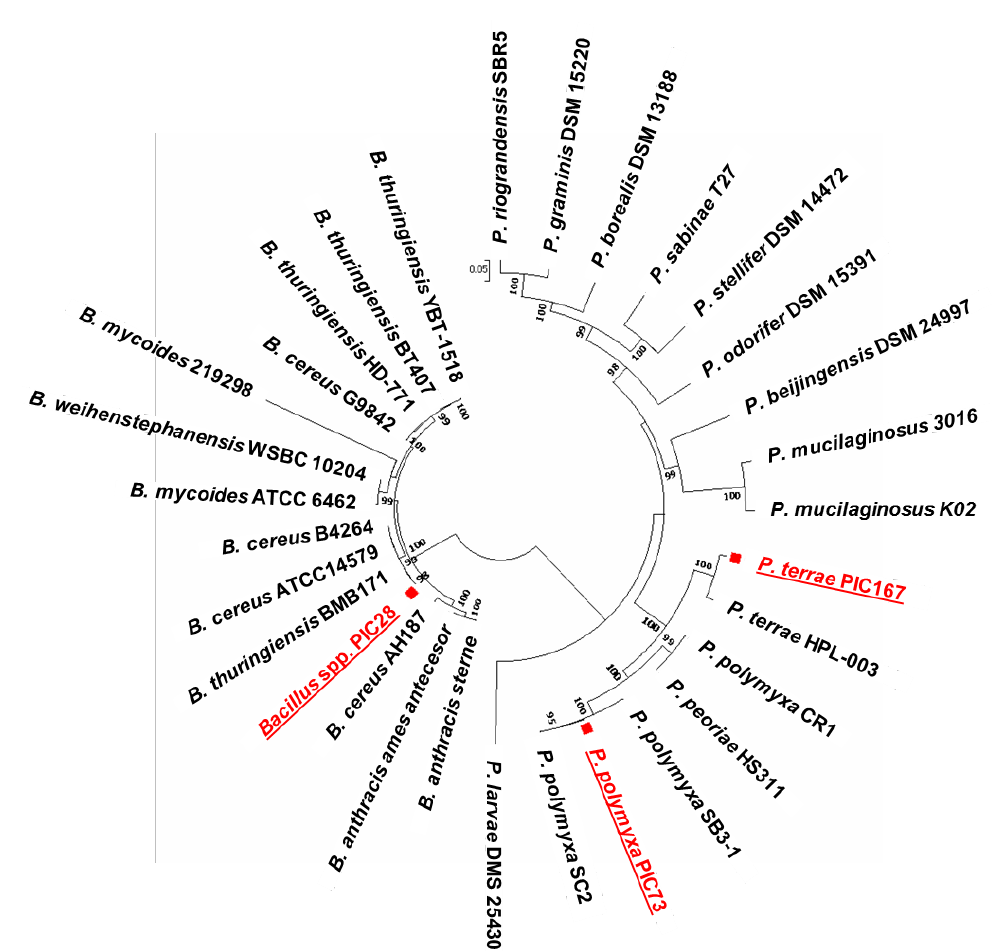
Figure 1. Circular phylogenetic tree showing the taxonomic position of the three novel Bacillales strains (underlined red color) isolated from olive ‘Picual’ roots. The tree was constructed by the Neighbor-Joining method, based on the alignment of concatenated partial sequences of gyrB , atpA , nusA , pyrH and dnaJ (see text for details). Bar indicates sequence divergence. Bootstrap values (≥95%) based on 1000 re-sampled datasets are shown at branch nodes. Paenibacillus larvae DMS 25430 was used as out-group.